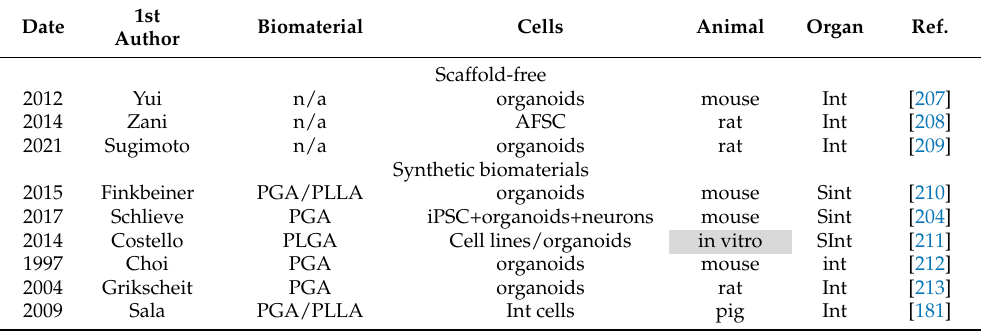
Table 5. Protocols for intestines